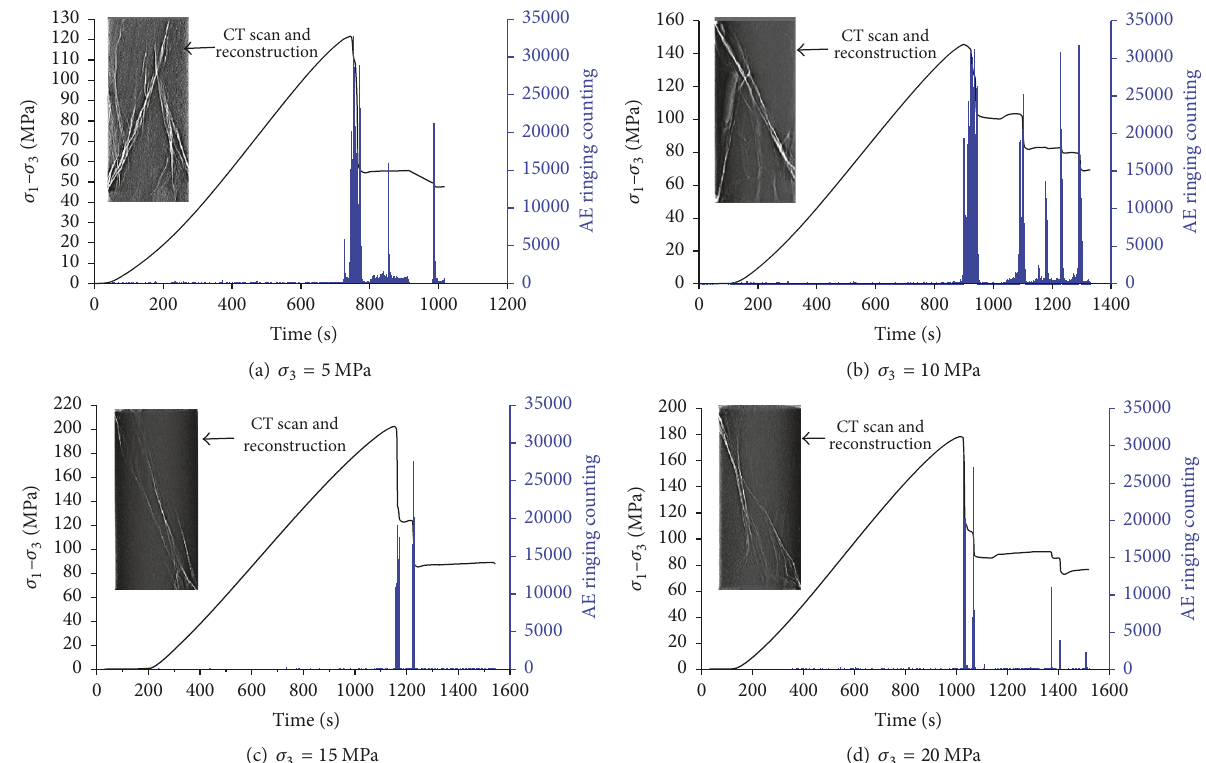
Figure 7: Test results of AE ringing counts of rock specimens under different confining